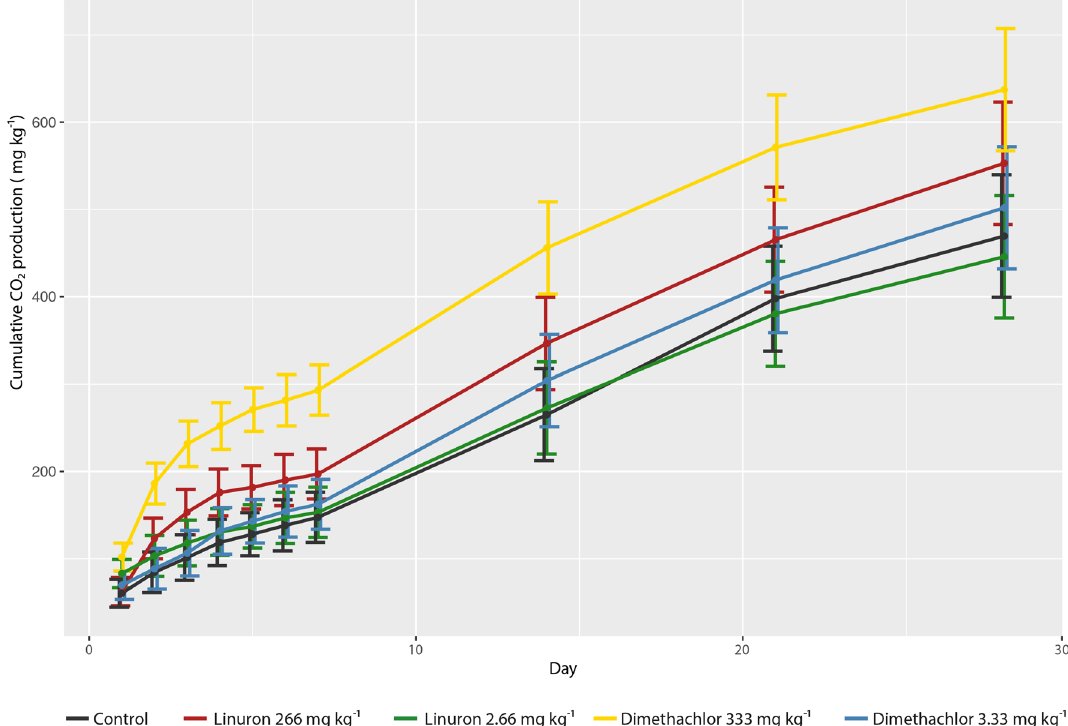
Figure 1. Cumulative CO 2 production in soil treated by herbicides linuron and dimethachlor during the 28 days after treatment. In each day, values were compared by one-way ANOVA and error bars indicate Tukey confidence